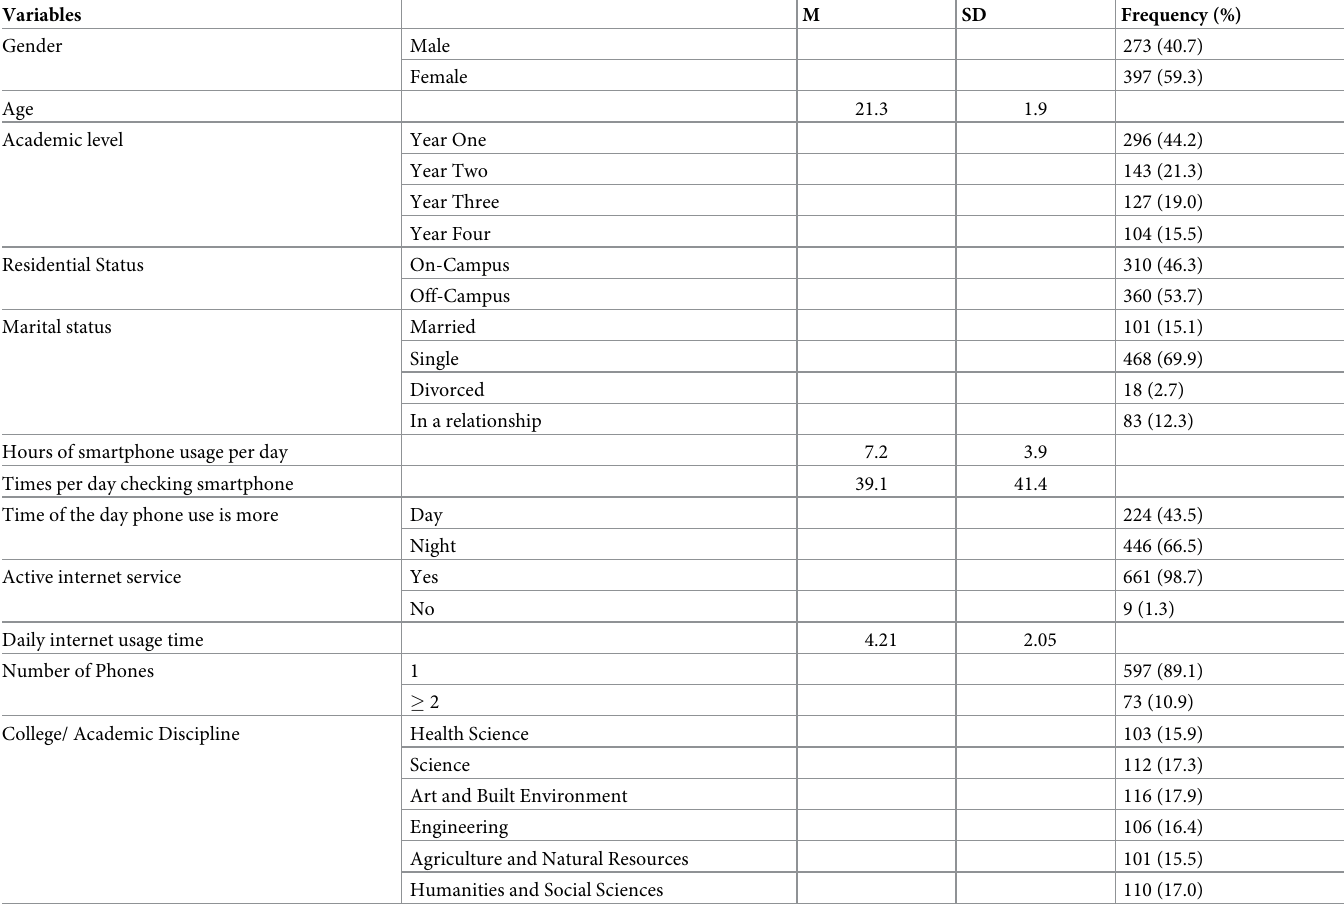
Table 1. Distribution of sociodemographic profiles of the